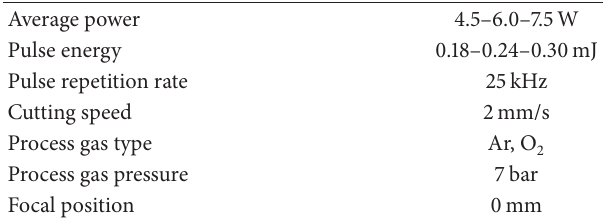
Table 2: Processing conditions for laser microcutting of